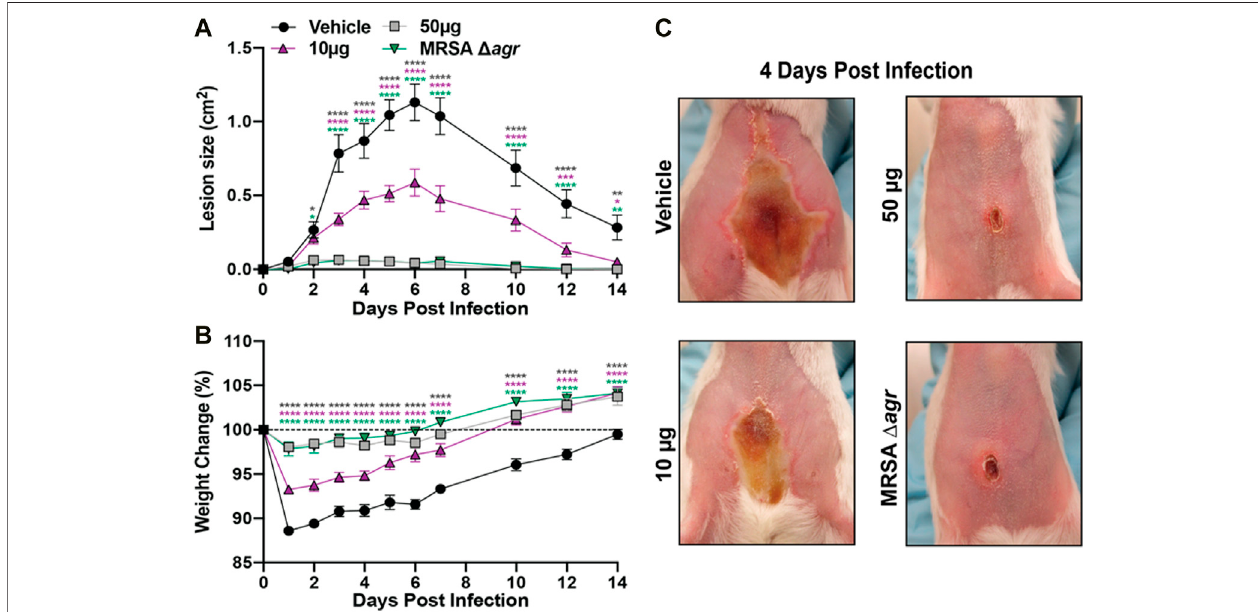
FIGURE 11 | Castaneroxy A ( 1 ) protects murine skin from MRSA-mediated dermonecrotic injury and morbidity. (A) Dermonecrotic lesion size over time for mice challenged with MRSA and a 10 µg or 50 µg dose of 1 (or vehicle control) or MRSA Δ agr at the time of infection. (B) Weight change for indicated groups over the two- week infection period. (C) Representative images of dermonecrotic lesion size and severity at day 4 post-infection. Data are pooled from two independent experiments ( n (cid:1) 10pergroup). MeanandSEMvaluesareshown.Two-way ANOVAwithDunnett ’ smultiplecomparisontestwasperformedcomparingthemeanofthevehicle control to the mean of each test group for each day of measurements. A p -value < 0.05 was considered signi fi cant. (* p ≤ 0.0332, ** p ≤ 0.0021, *** p ≤ 0.0002, **** p ≤